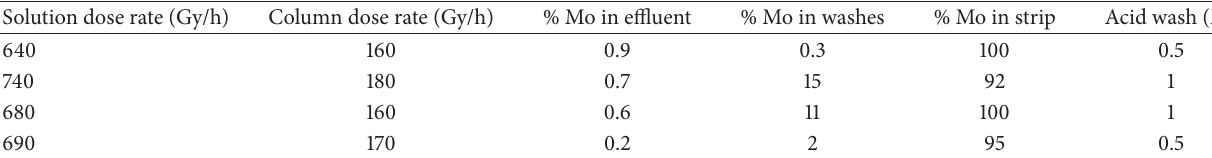
Table 3: Results for Van de Graaff column experiments.